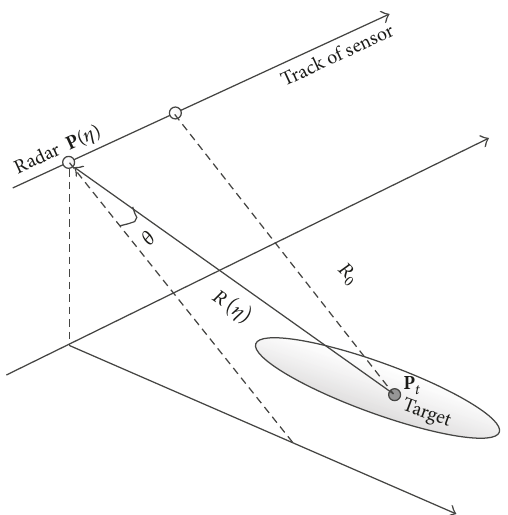
Figure 1: SAR geometry. The radar travels along its course at an altitude with a constant velocity 𝑉 𝑇 and the radar transmits and receives pulses with a squint angle of 𝜃 . The center of the imaging area is 𝑃 𝑡 , and the nearest slant distance between 𝑃 𝑡 and the radar is 𝑅 0 . The motion of the radar relative to the target results in RCM, which is the intrinsic feature of SAR and, however, must be